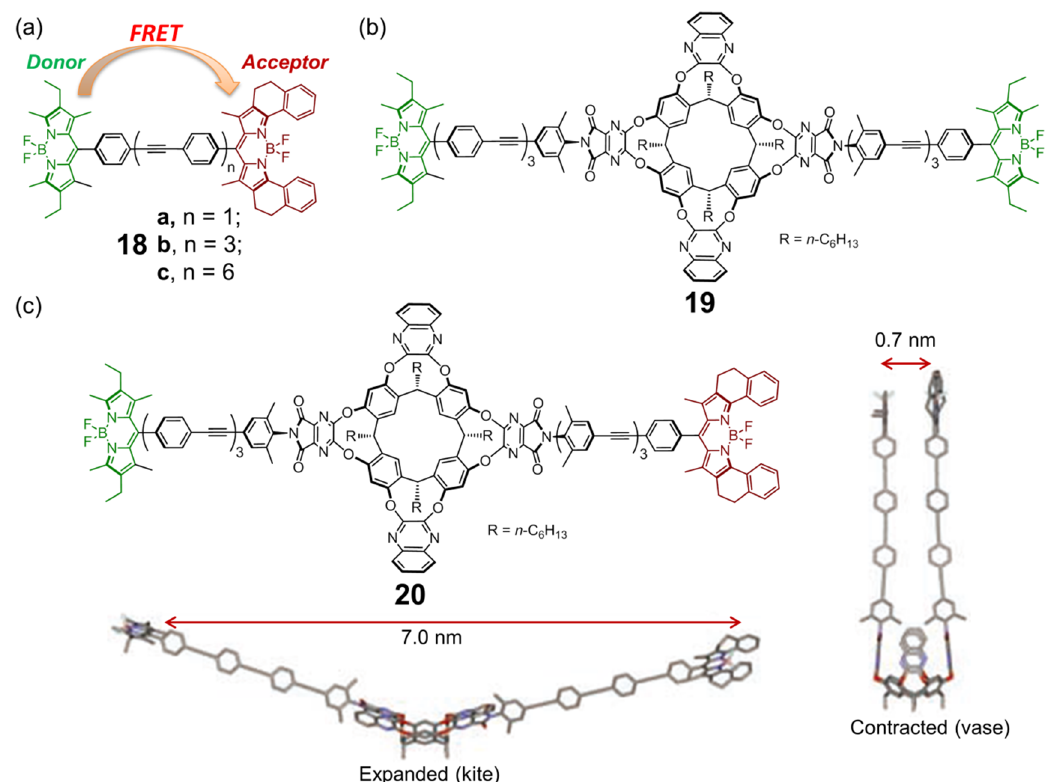
Figure 14. Chemical structures of BODIPY-decorated resorcin[4]arenes 15–17 .